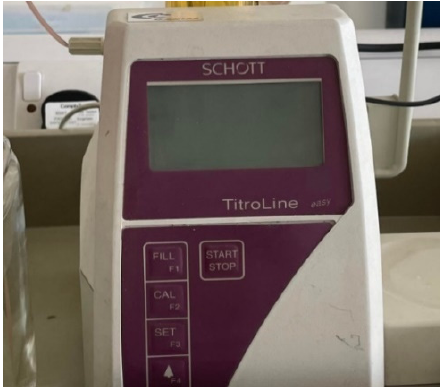
Figure 7. Acid number titrator in GCU